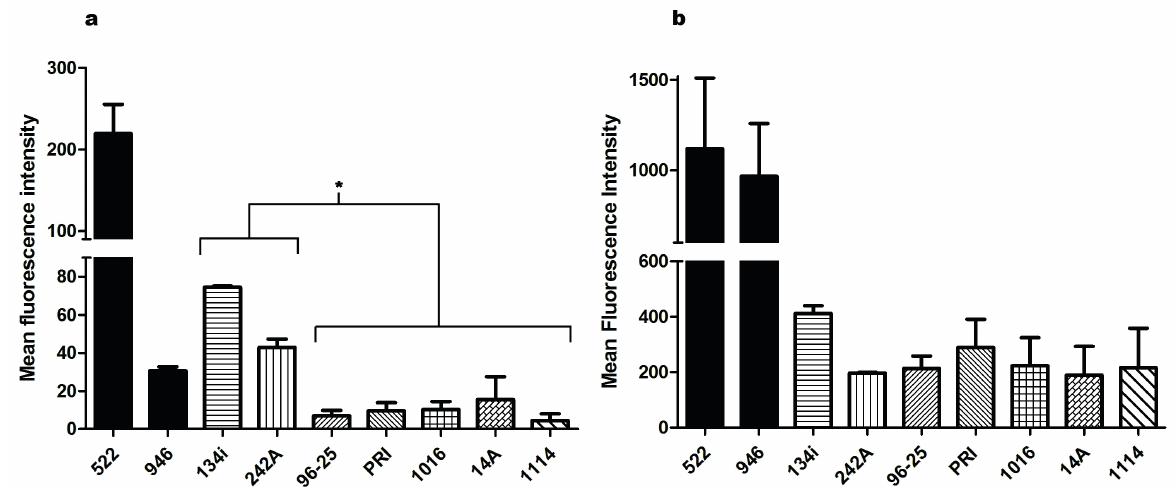
Figure 2 - Mean fluorescence intensity of C. albicans isolates after treatment with nile red or rhodamine 6G. C. albicans strains PRI, 1016, 1114 and 14A were not able to retain nile red, as well as control strain 96-25 ( a ). The four tested strains retained rhodamine 6G, as well as control strains 134i and 242A ( b ). Saccharomyces cerevisiae strains 522 and 946 were used as control. Results are representative of at least four independent experiments. (*) p >